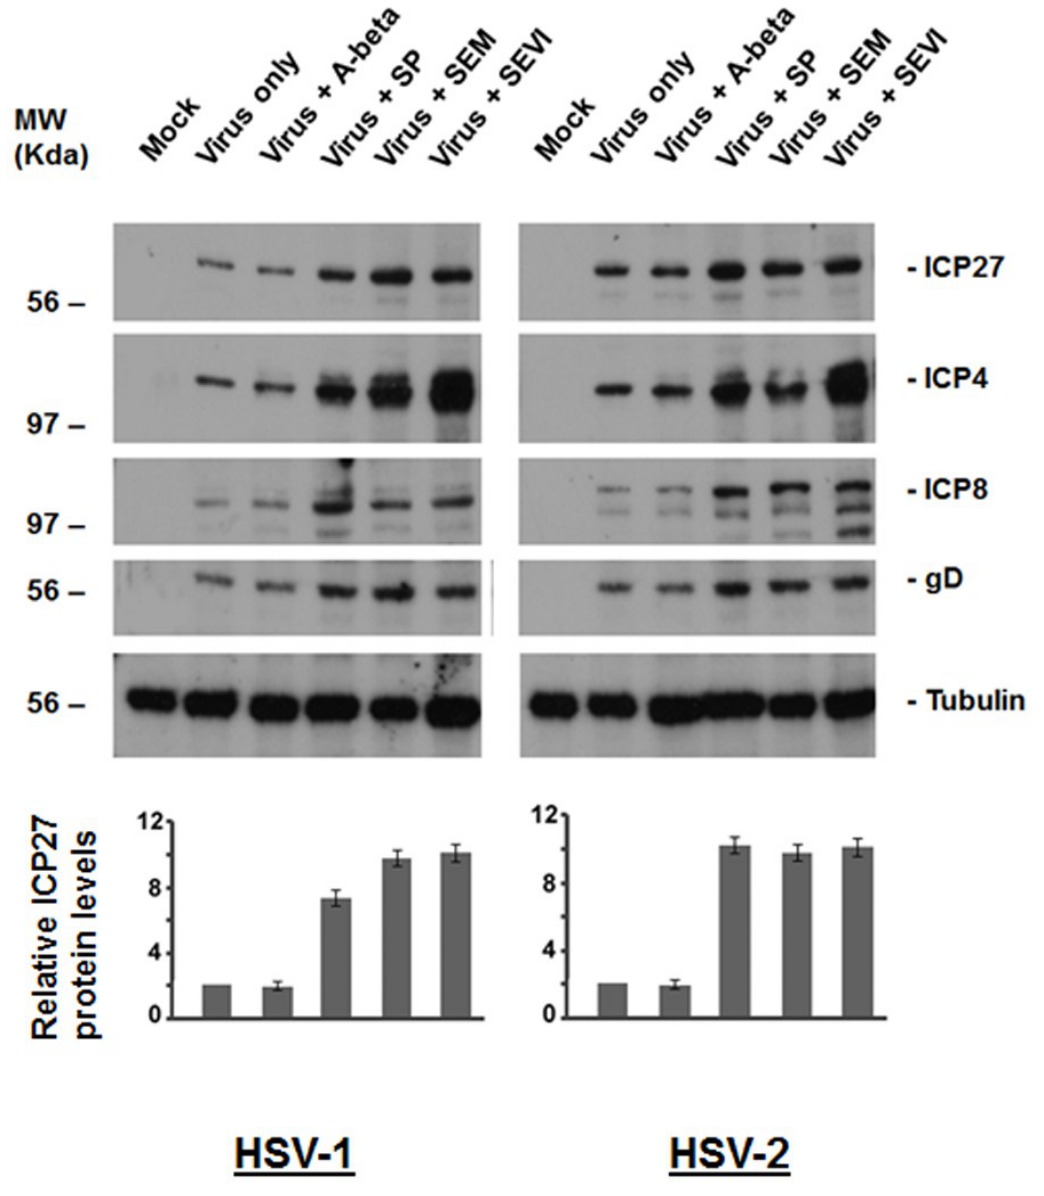
Figure 2. Western blot assay to detect viral protein production. ( Left ) HEK 293T cells were mock-infected or infected with either HSV-1 alone (MOI = 0.1) or HSV-1 treated with SP, A-beta, SEM amyloids, or SEVI for 24 h. Whole cell lysates were prepared for Western blot using antibodies against ICP27, ICP4, ICP8, gD, and tubulin (as loading control). ( Right ) The same as that in the left, but using HSV-2 instead of HSV-1; ( Bottom ) By comparing the density of the ICP27 bands of HSV-1 or HSV-2 with that of the virus alone (with all intensities normalized to the tubulin control), the fold-increases of ICP27 levels for HSV-1 (left) and for HSV-2 (right) were calculated (Quantity One software, version 4.5.0, Bio-Rad Laboratories, Richmond, CA, USA). Normalized ICP27 levels are shown below the corresponding Western